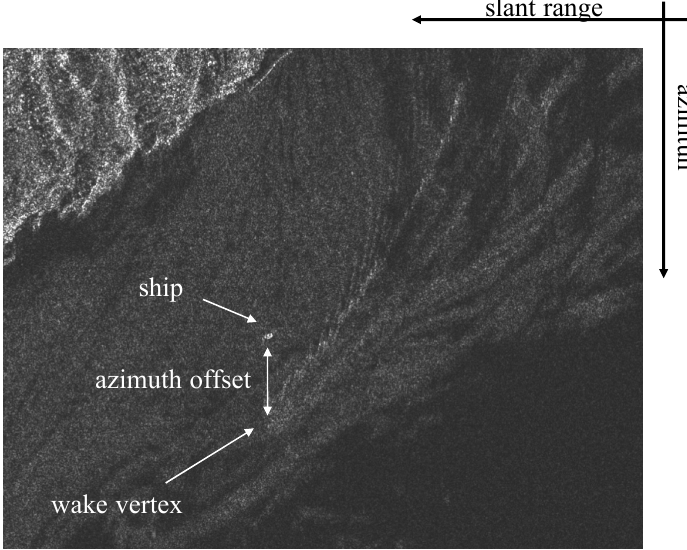
Figure 1. Example of a ship imaged by TerraSAR-X satellite over the Gulf of Naples (3 August 2012). The ship shows a negative azimuth offset with respect to its wake vertex (true ship position).